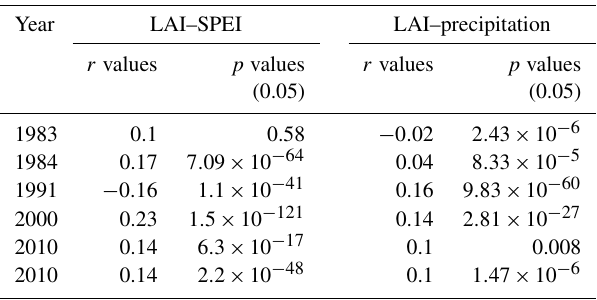
Table 5. Pattern correlation coefficients ( r values) and significance of the coefficients calculated at a significance level of 5% ( α = 0 . 05) between the LAI and SPEI for extremely dry and wet years, as well as between the LAI and precipitation during extremely dry and wet years. The correlation coefficients are significant when the p value is less than